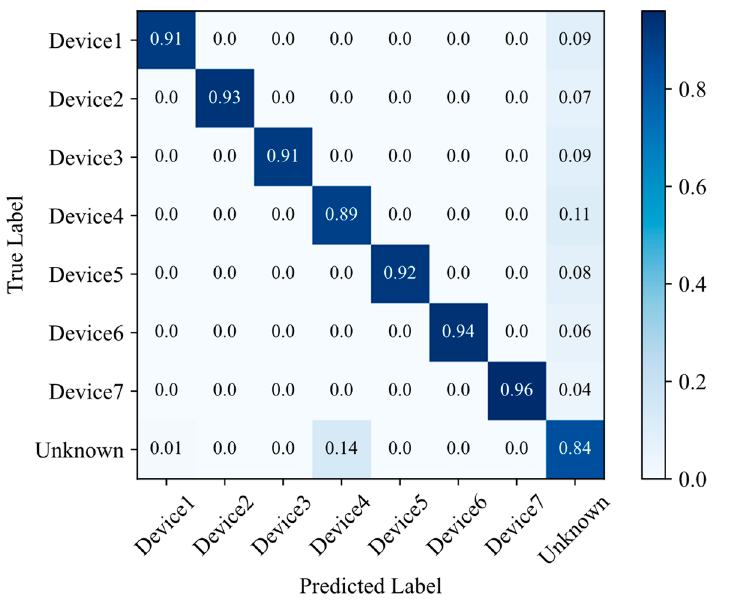
Figure 11. Confusion matrix under mixed SNRs of − 4–10 dB.